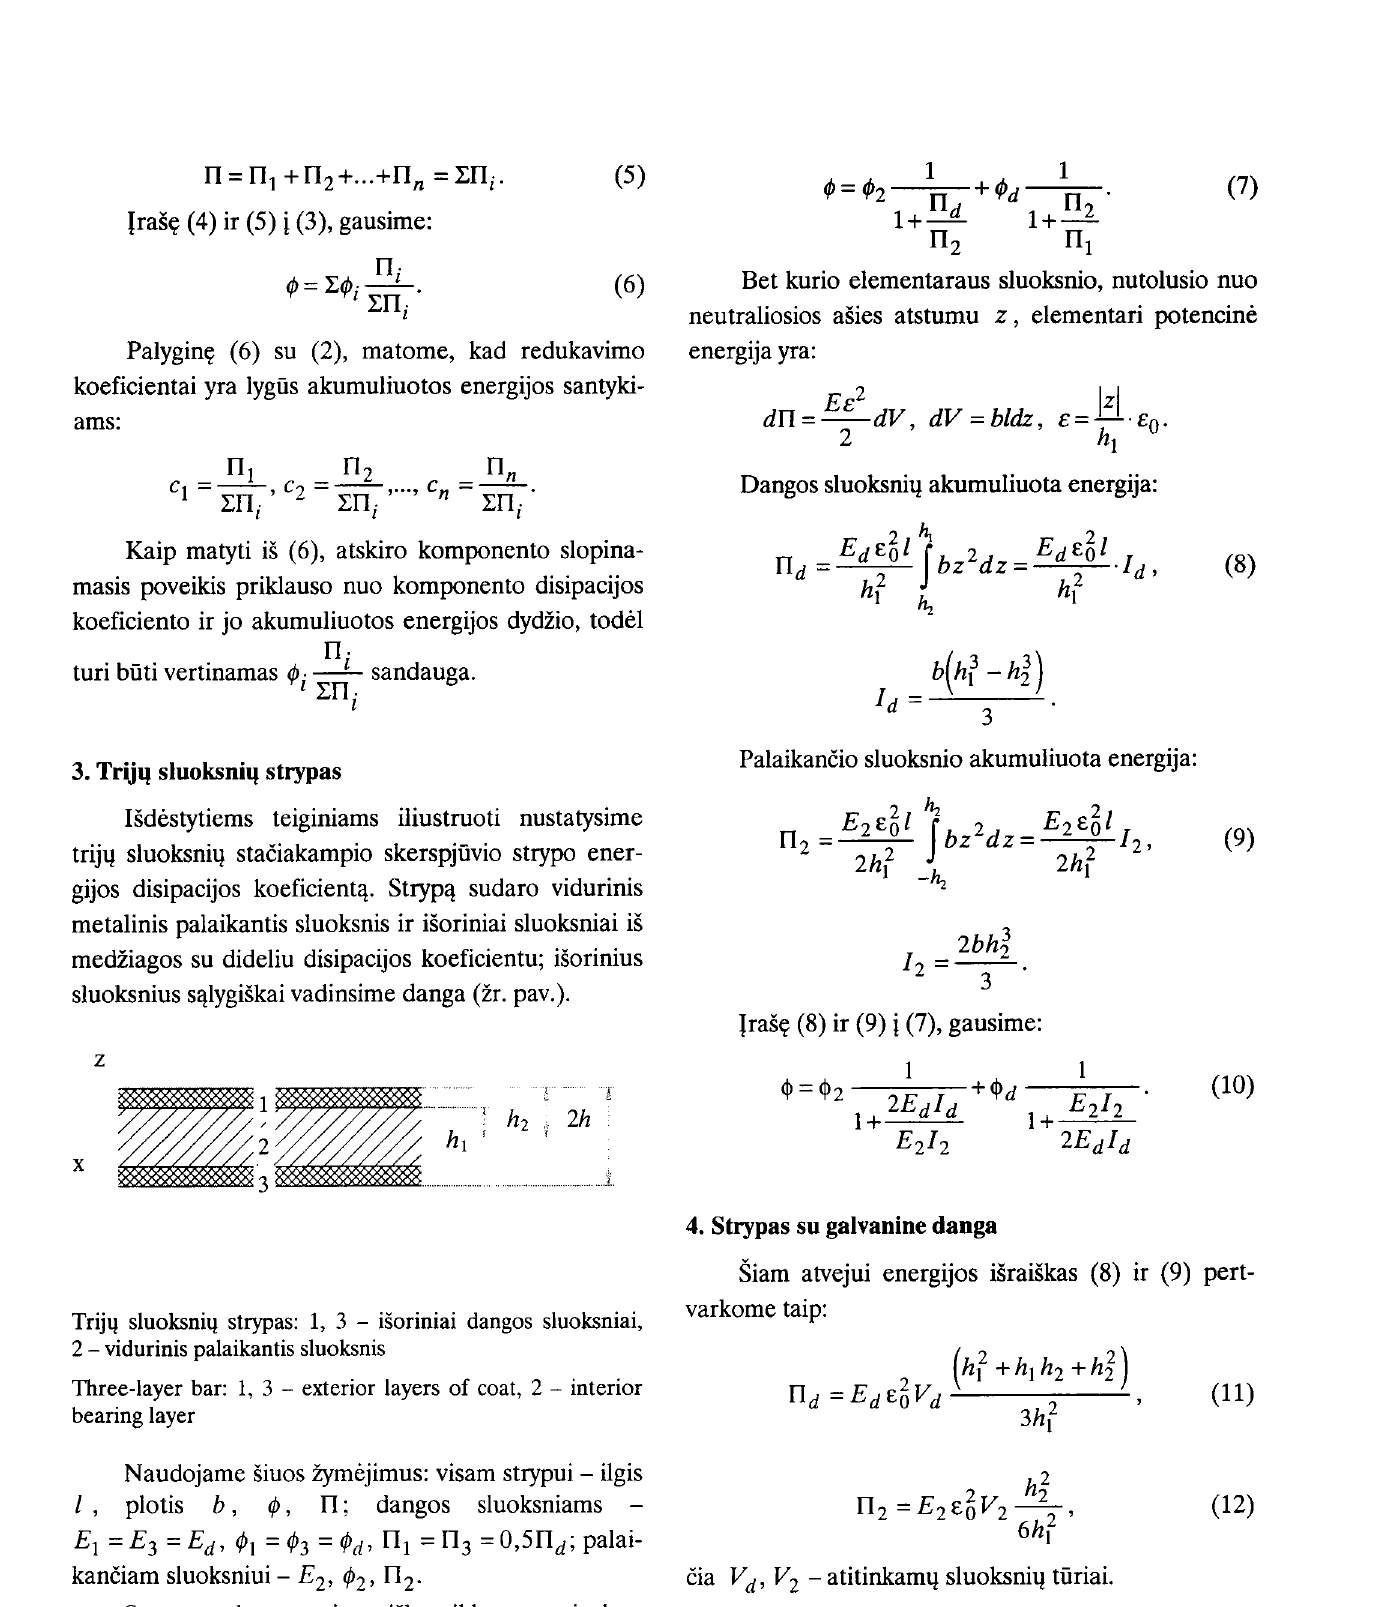
Three-layer bar: 1, 3 - exterior layers of coat, 2 - interior bearing